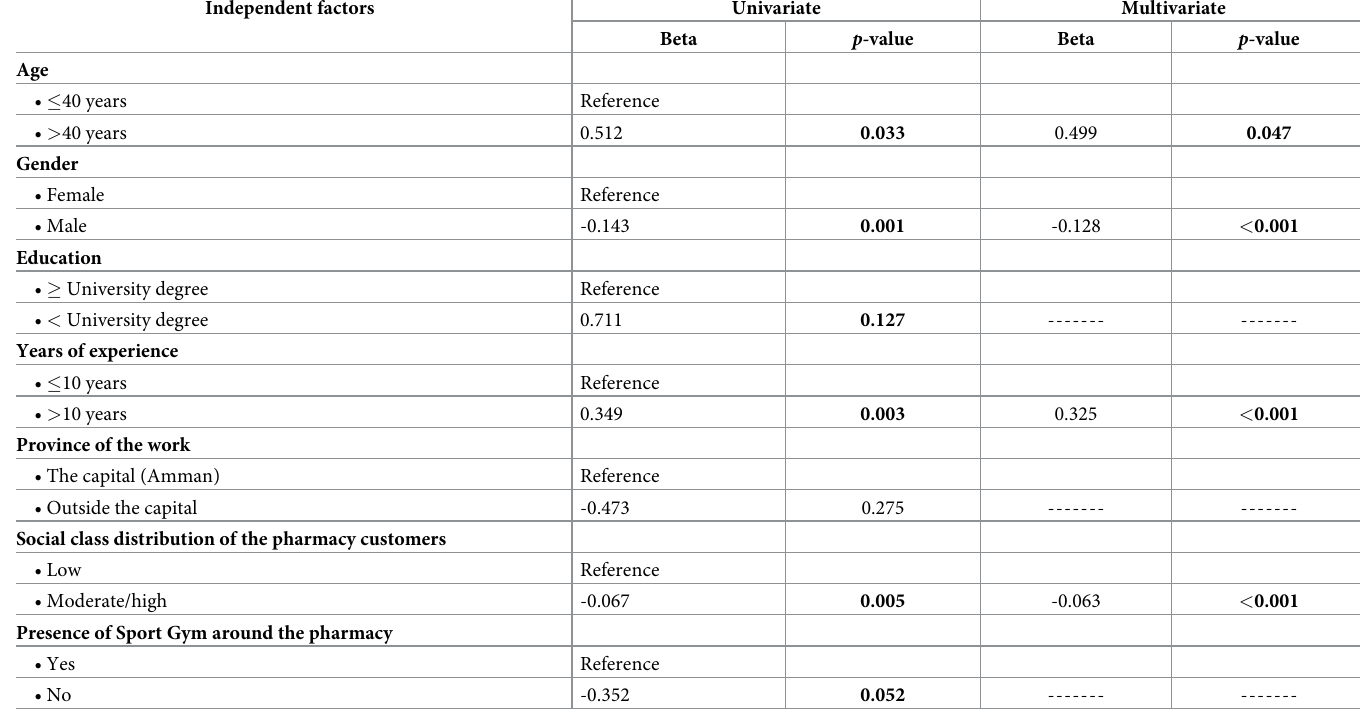
Table 4. Summary of the logistic regression analysis (Univariate and Multivariate) to assess predictors associated with the exposure of participating pharmacists to OCPs use among